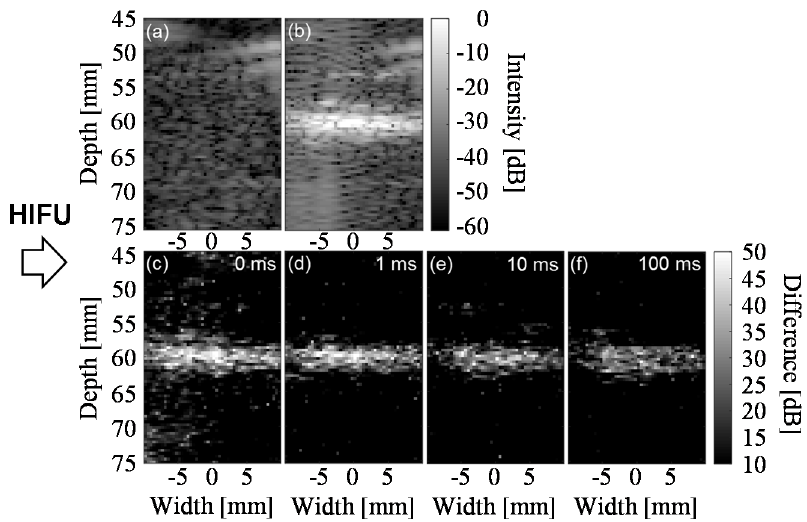
Figure 6. High-speed pulse inversion (PI) images with two-plane wave transmissions of a PAA gel phantom containing a 0.5% graphite layer with a thickness of 0.75 mm [36]. ( a , b ) PI images before and 0.9 ms after the stop of the trigger pulse exposure, respectively; ( c – f ) difference PI images between before and 0.9 ms after the stop of the heating burst exposure with durations of 0, 1, 10, and 100 ms, respectively.